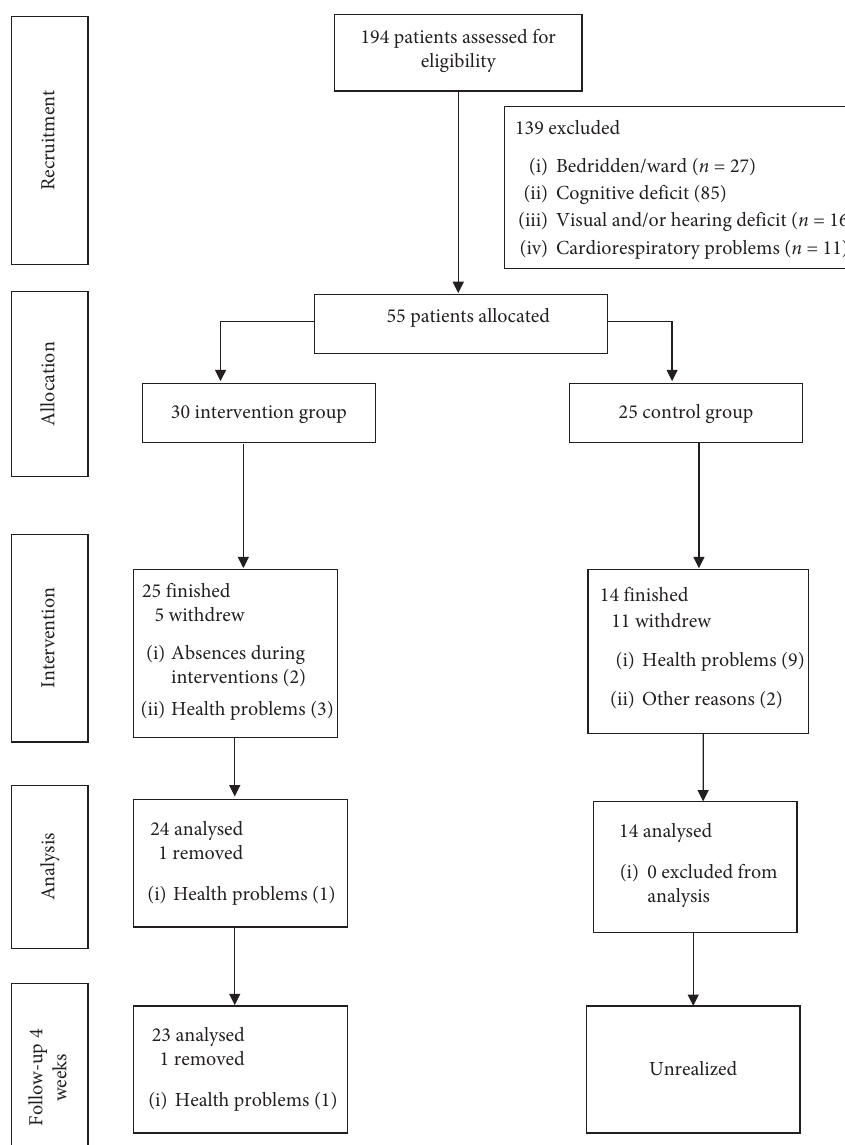
Figure 1: Consort diagram with participant